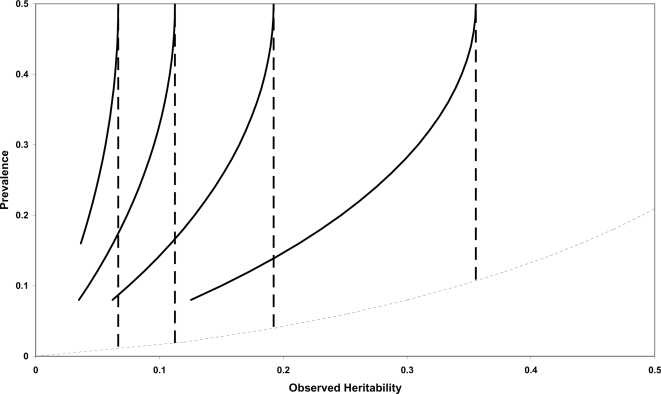
Predicted accuracy of estimated genetic risk from population and case control designs of a dichotomous phenotype.Contour plot of predicted accuracy for varied prevalence and additive heritability on the observed scale, in population studies (dashed vertical line) and case control studies (solid line) of dichotomous phenotypes. Each contour represents a line of constant accuracy, starting from the right 0.9, 0.8, 0.7, and 0.6. The narrowly dashed line is derived from Equation (5) with , so values below this line are not possible under the liability model.